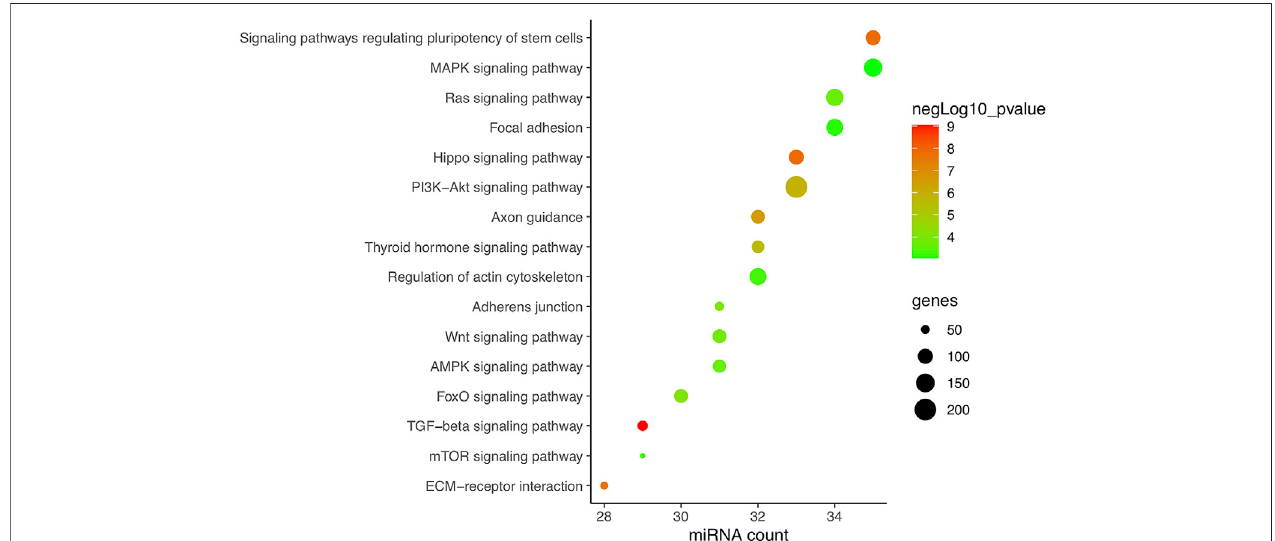
FIGURE 3 | KEGG enrichment of CFS miRNAs corroborating the reliability of bioinformatics. Pathways are ranked according to p -value, and the top 22 are displayed after fi ltering those relating to cancer and chemical synthesis. KEGG terms included are highly consistent with veri fi ed FR pathways at present. Pathways excluded are proteoglycans in cancer, pathways in cancer, fatty acid biosynthesis, mucin-type O -glycan biosynthesis, morphine addiction, and melanoma (nos. 5, 6, 8, 11, 18, and 21,